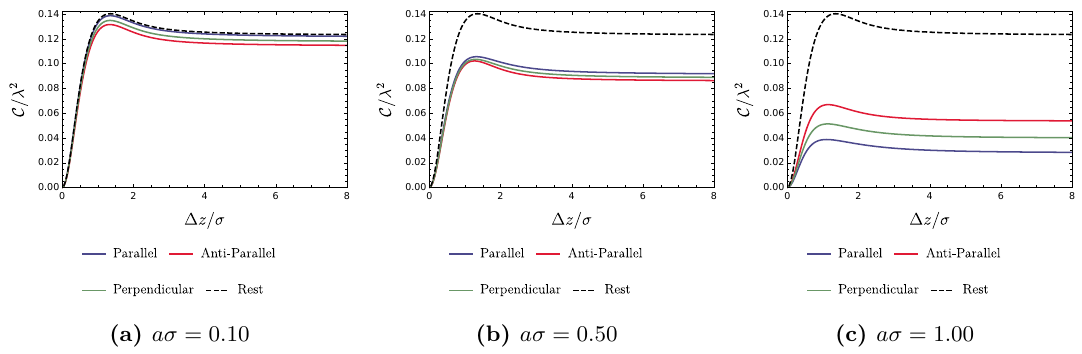
Figure 8. The concurrence is plotted as a function of ∆ z/σ with fixed Ω σ = 0 . 10 , ∆ d/σ = 1 . 00 , and aσ = { 0 . 10 , 0 . 50 , 1 . 00 } from left to right. In the limit of ∆ z → 0 , the concurrence C ( ρ AB ) in all acceleration scenarios will approach zero regardless of the values of acceleration a . Obviously, there is a peak of concurrence near ∆ z/σ ∼ 1